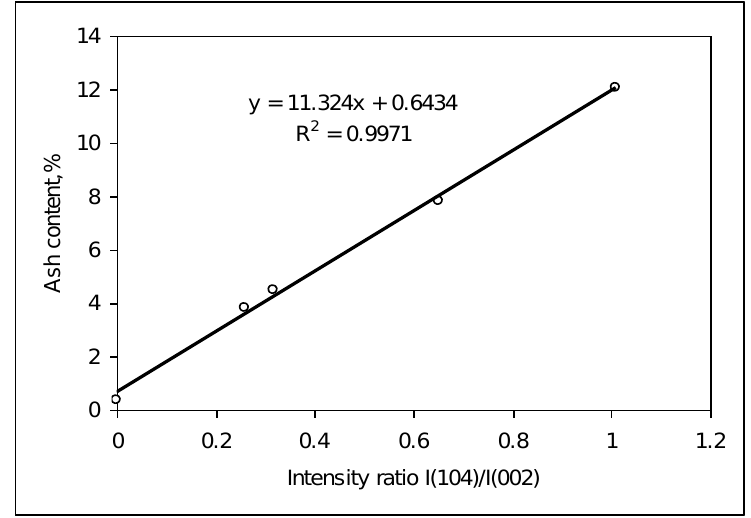
Figure 8. Correlation between ratio of I104/I002 diffraction intensity and ash content of paper samples filled in-situ and washed with an acid